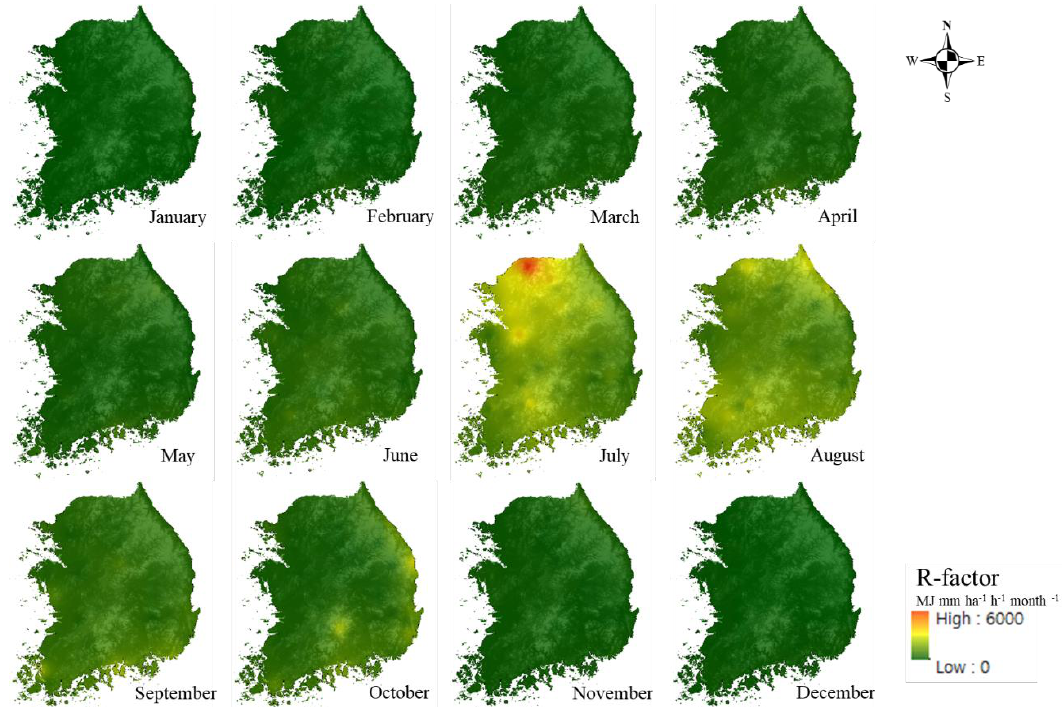
Figure 4. Spatial distribution of monthly R-factor calculated by USLE, using rainfall data from 50 weather stations for the period 2013–2019.